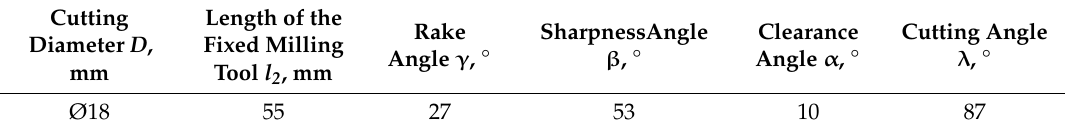
Table 3. Characteristics of the fixed milling tool.